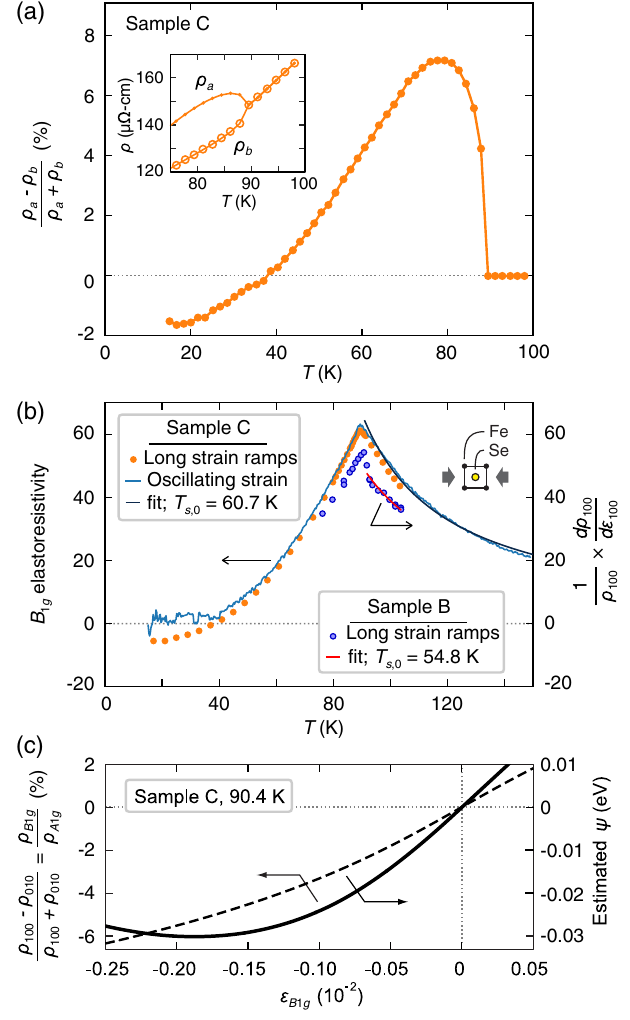
FIG. 8. Nematic resistive anisotropy. (a) The spontaneous resistive anisotropy below T , obtained from T -ramp data as s and ρ near T . (b) B 1 described in the text. The inset shows ρ a b s g Þ d ρ =d ε elastoresistivity, ð 1 = ρ , obtained from both long A 1 g B 1 g B 1 g strain ramps and from a small oscillating strain. For sample B, ρ ð 1 = ρ Þ × 010 was not measured, so the [100] elastoresistivity 100 d ρ 100 =d ε 100 is plotted instead. Fits are to a Curie-Weiss form; see the text. (c) Resistivity anisotropy of sample C against strain at ¼ 0 at T ≈ T . The curve has been shifted vertically to set ρ s B 1 g ε ¼ 0 , canceling a small geometrical error in the measurement. B 1 g Also shown is an estimate of the strain-induced nematicity ψ , taken as the xz - yz energy splitting at the X point, obtained from evaluation of Ginzburg-Landau